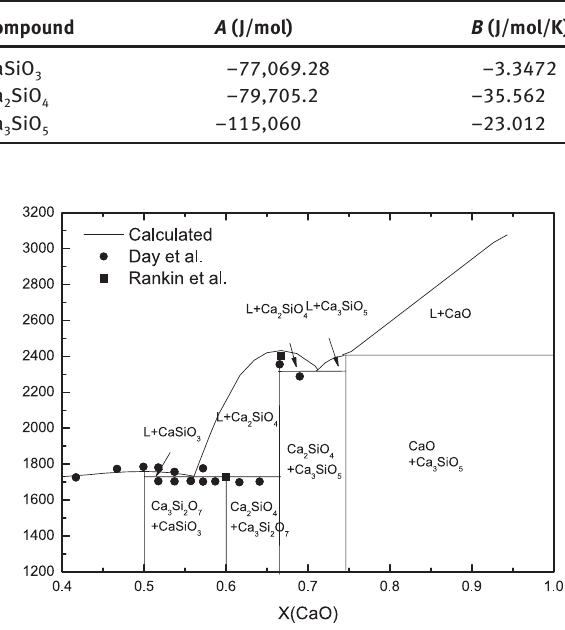
Fig. 6: Comparison between calculated CaO-SiO 2 phase diagram and phase diagram in literature [24, 25].